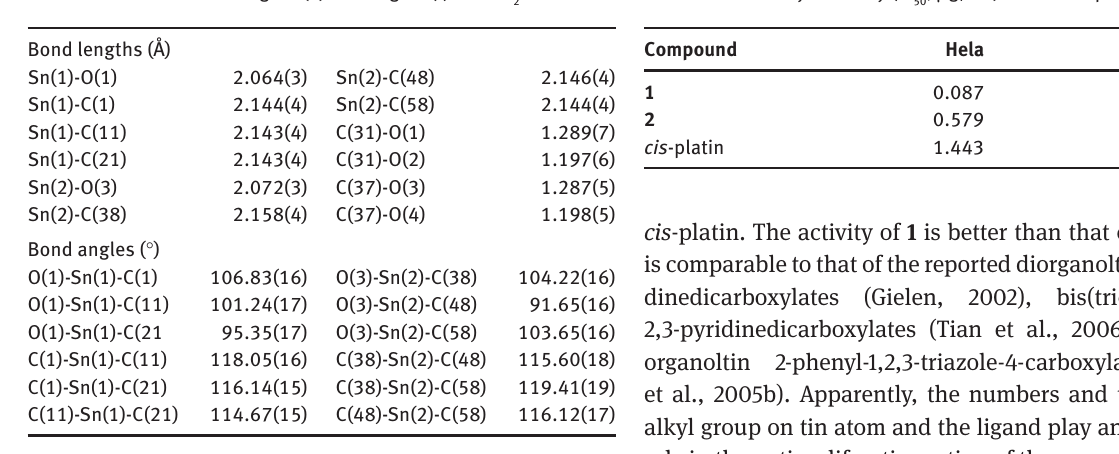
Table 1 Selected bond lengths (Å) and angles ( ° ) for 2 ·H